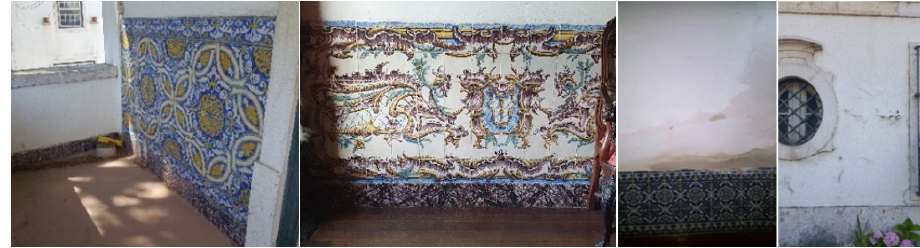
Figure 10. Decorative ceramic tiles applied to wall surfaces and detection of deterioration.